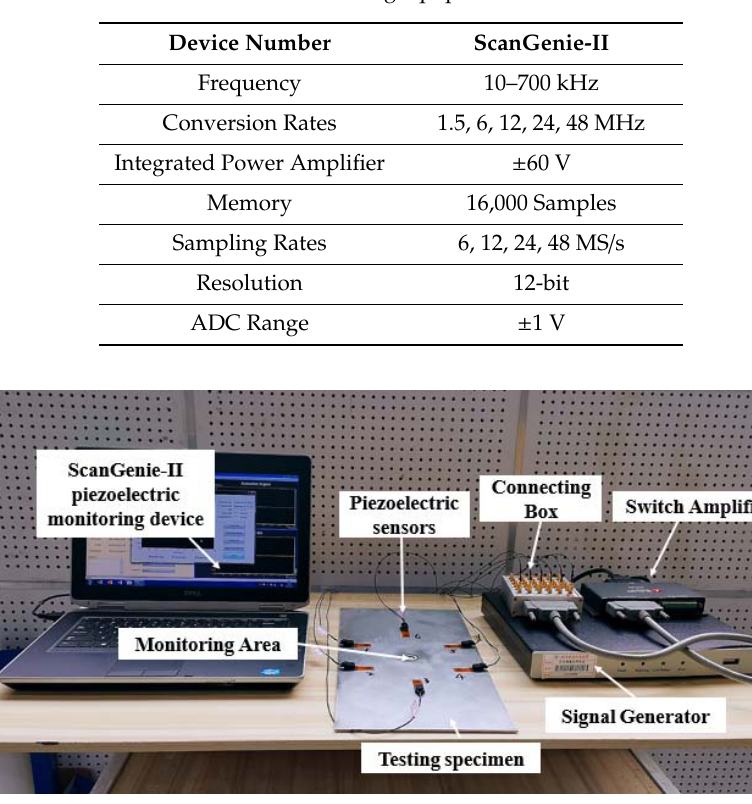
Table 1. Piezoelectric monitoring equipment technical indicators.